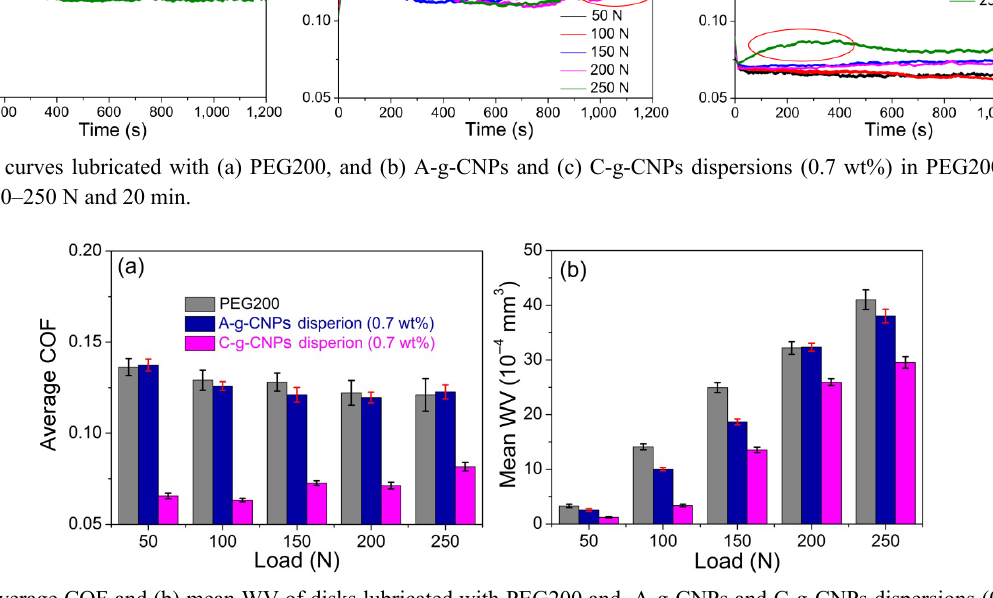
Fig. 11 (a) Average COF and (b) mean WV of disks lubricated with PEG200 and, A-g-CNPs and C-g-CNPs dispersions (0.7 wt%) in PEG200 under the conditions of 50–250 N and 20